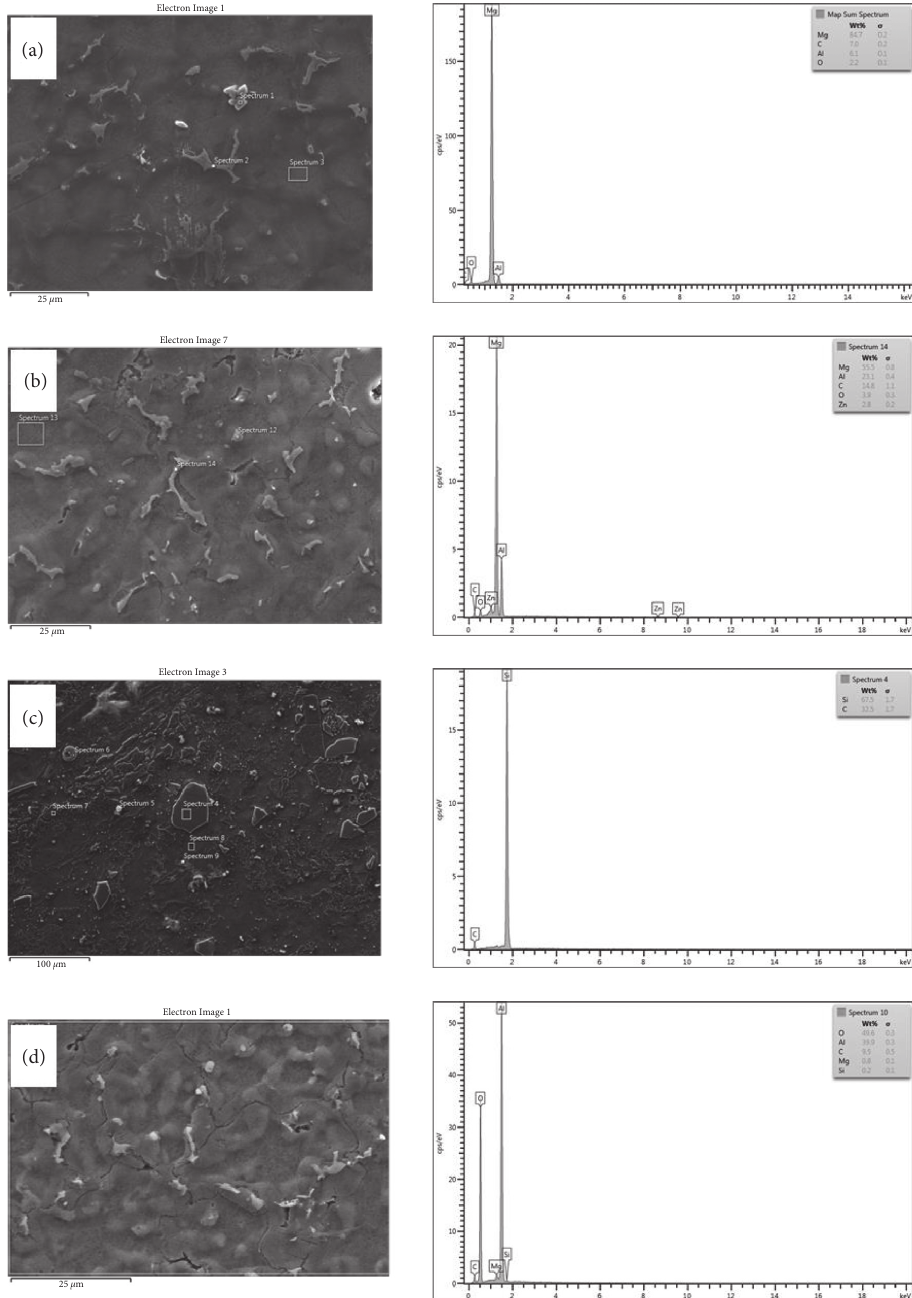
Figure 4: SEM morphological analysis and EDX analysis of samples. (a) Mg alloy. (b) Coated Al